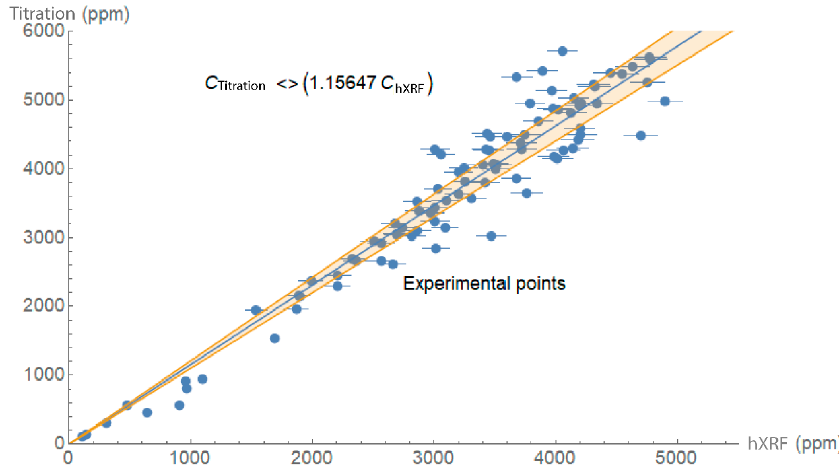
Figure 3. Chloride ions found by titration vs. chloride ions quantified by hXRF (correlation coefficient, R 2 = 0.92, 90.0% confidence interval).